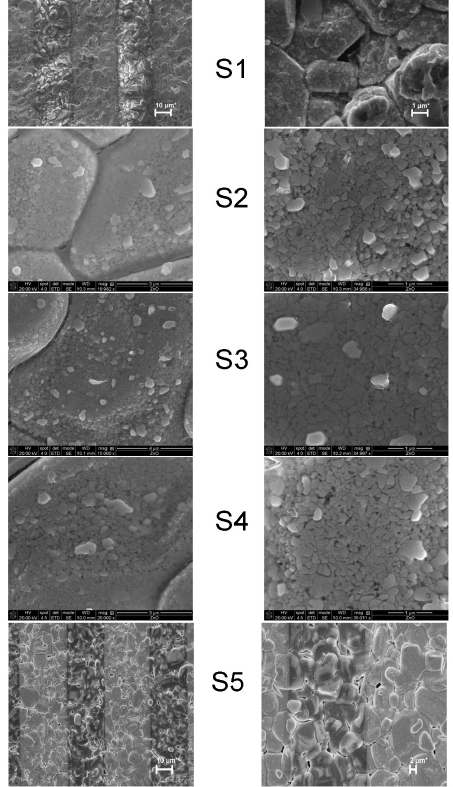
Figure 25. SEM images of the investigated sensors (S1–S5). Gold interdigits appear as dark grey stripes., from ref. [126].